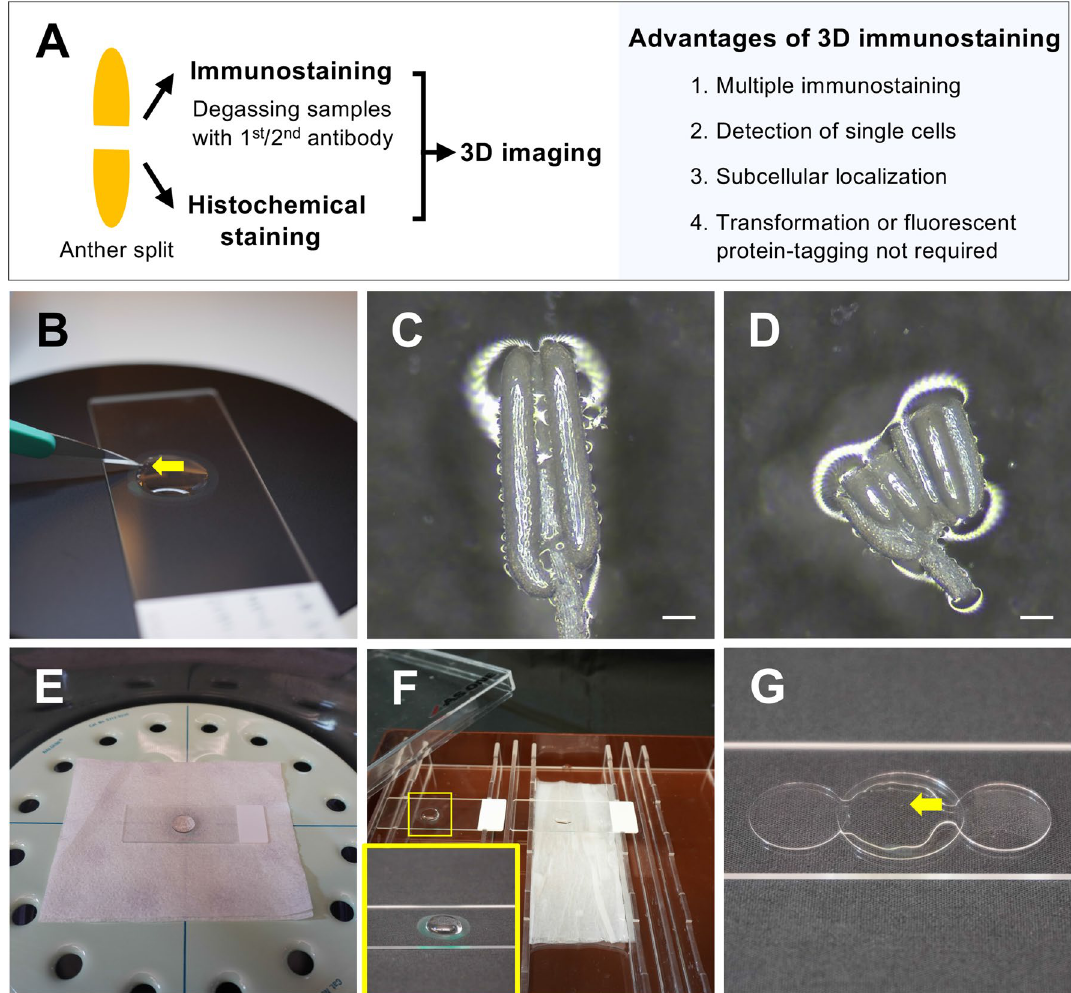
Figure 2. Equipment used for 3D multiple immunostaining and splitting anthers. ( A ) Flow chart and advantages of the 3D multiple immunostaining method. ( B ) Anthers being split using a scalpel (arrow) on a MAS-coated slide under a stereo microscope. ( C ) A 4% PFA-fixed anther in distilled water before the split. ( D ) The two parts of an anther after the split. Scale bars, 100 μm. ( E ) Samples with primary/secondary antibody solution in a vacuum desiccator. ( F ) Samples without coverslips placed in a humidified box for primary/ secondary antibody incubations. Yellow-lined square shows an enlarged image of the antibody treatment on the slide. ( G ) Mounting of samples. Two additional coverslips were placed on either side of the sample to maintain the structure of anthers without crushing them. Yellow arrow indicates the split